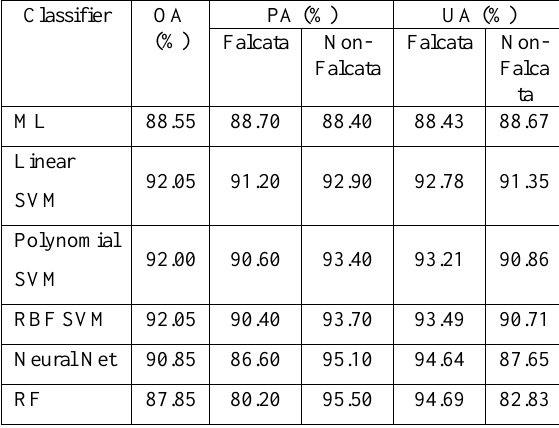
Table 3. Summary of accuracies for the 20-m resolution Sentinel-2 image